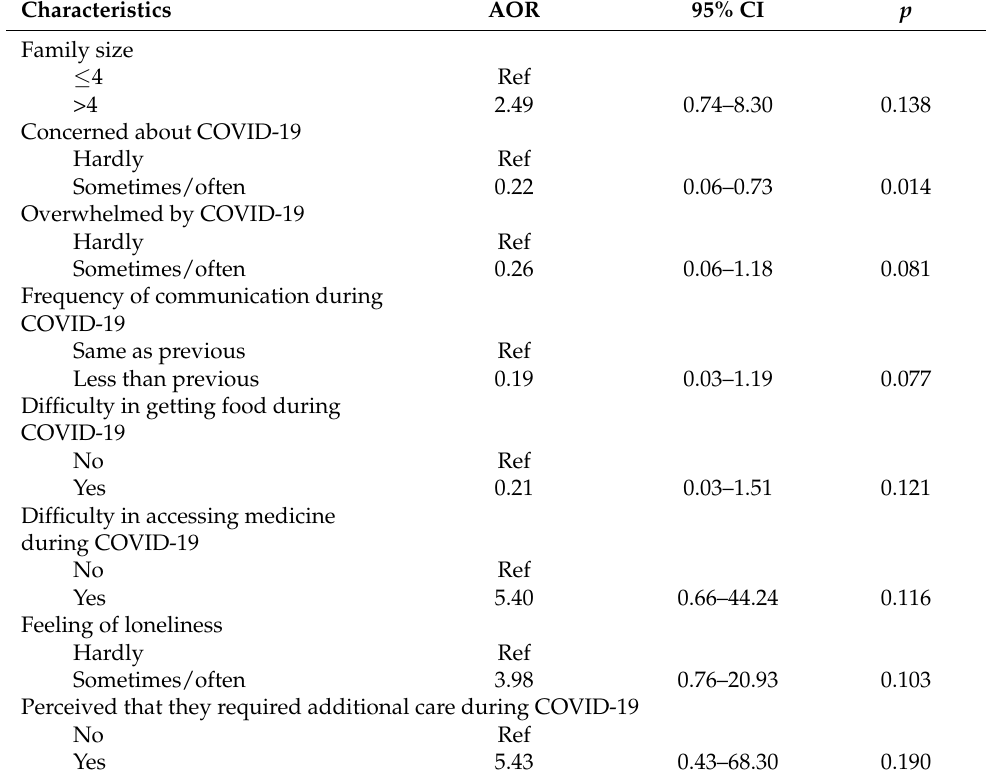
Table 2. Factors associated with increased tobacco use during COVID-19 (N =